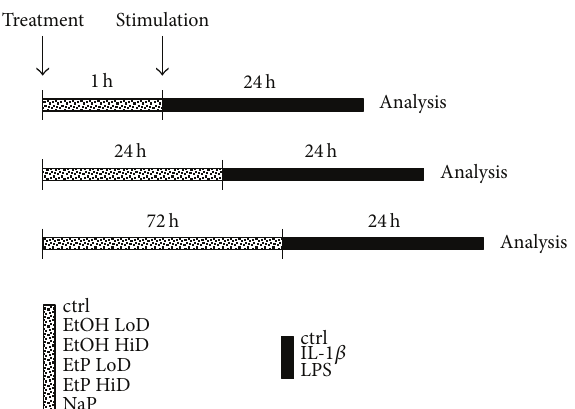
Figure 4: Schematic timeline of the experimental design. Cells were treated with EtOH (low dose, LoD = 85 mM and high dose, HiD = 170 mM), EtP (LoD = 2.5 mM and HiD = 10 mM), or NaP (10mM) for 1h, 24 h, or 72 h and then stimulated with IL-1beta (1ng/mL) or LPS (1 𝜇 g/mL) for 24 h. After the incubation periods, the analyses were